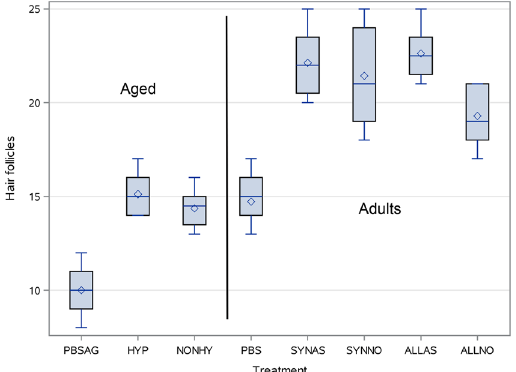
Figure 5. The number of hair follicles in healed wounds. SYNAS – young, syngeneic cells + AA,